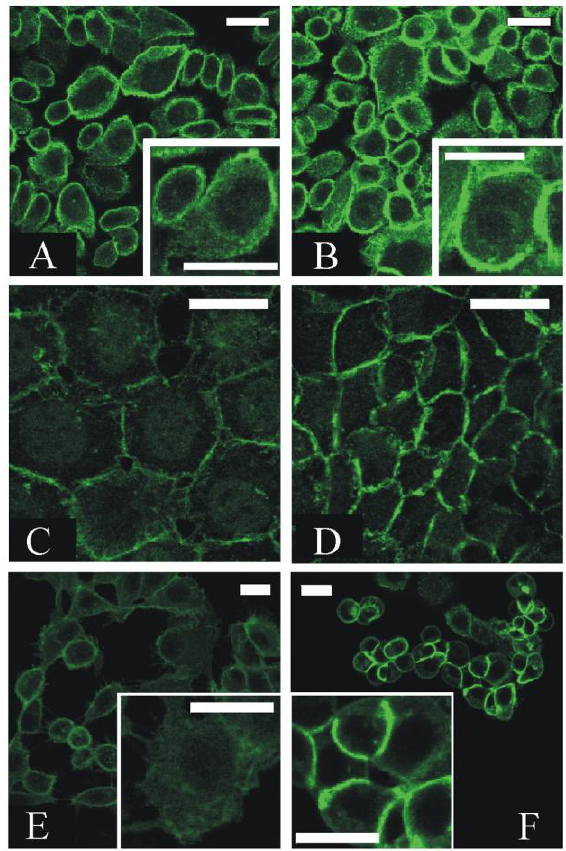
FIGURE 5 . Effect of NAC treatment on β-catenin increase and relocation. β-Catenin labeling in NHEK (A,B), Caco-2 (C,D) with details at higher magnification in the lower insets, and OVCAR-3 (E,F) after 3 days of growth. Control cells in the left column (A,C,E) and after 3 days from NAC treatment in the right column (B,D,F). NHEK grown in the presence of 2 mM NAC (B) show an increased number of intercellular junctions, with bound β-catenin. In Caco-2 cells grown in the presence of 5 mM NAC (D), the intracellular localization of β- catenin was also greatly affected, with redistribution from the nucleus to adherens junctions. From the image analysis, the fluorescence intensity increased of a factor of 7 relative to controls. A morphological change can be also observed, with smaller and more polygonal cells after NAC treatment. After 3 days from a 5 mM NAC treatment, OVCAR-3 cells (F) show the β-catenin disappearance from the nucleus, while it increases at the level of cell-cell junctions. From the image analysis, β- catenin fluorescence intensity at the junctions increases a factor of 30 with respect to controls. Morphological changes can be observed, from large and flat to smaller and regularly polygonal. Bars: 25 µm. Redrawn from Parasassi et